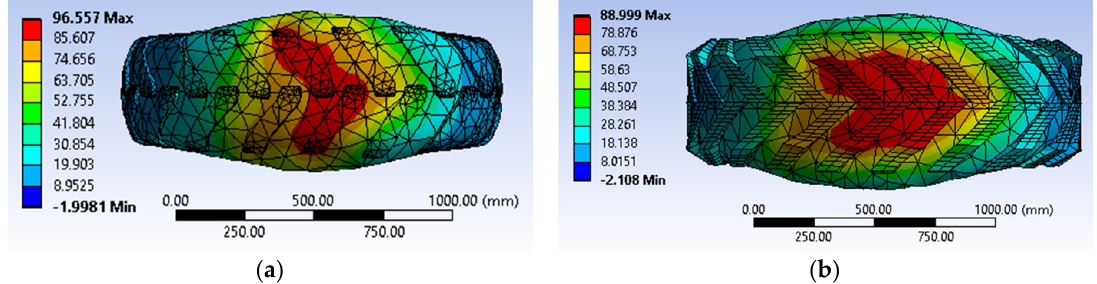
Figure 9. Examples of simulation of the 3D FEM tyre footprint for 420/85 R24 ( a ) and 460/85 R34 tyres ( b ) at the inflation pressure of 1.0 bar.